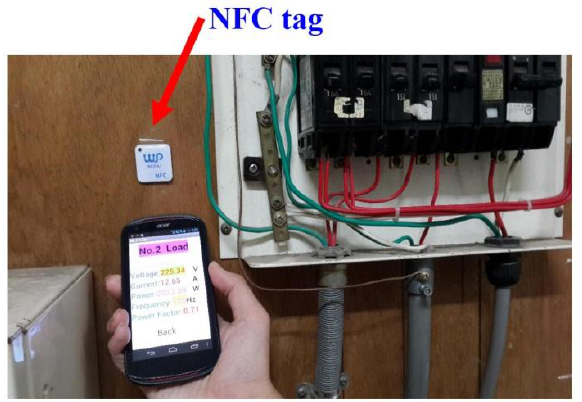
Figure 32. Actually the case of the measured Load 2.